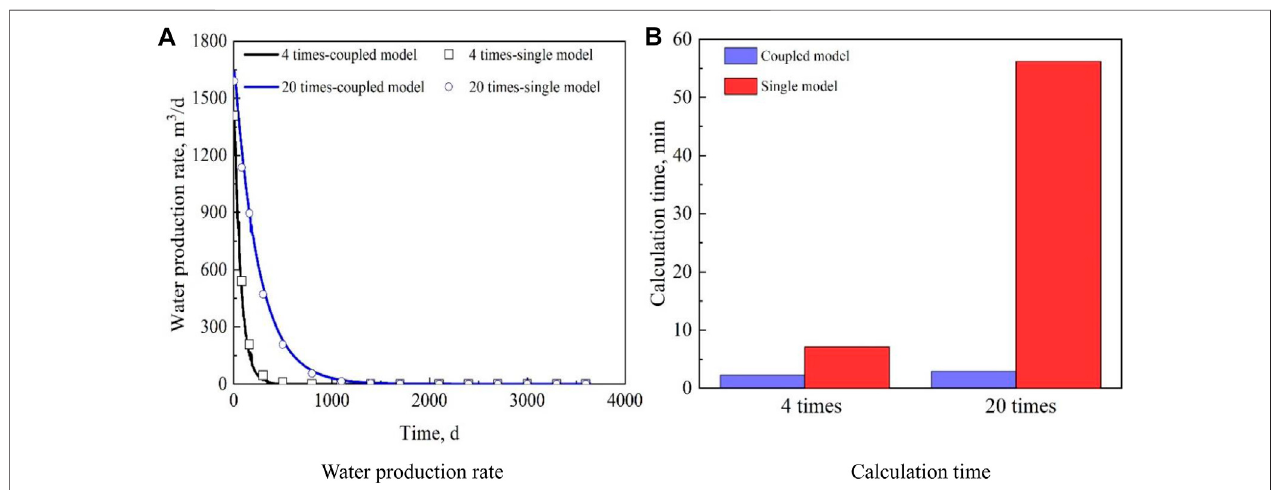
FIGURE 3 | Simulation results and calculation time comparison of the coupled model and single model. (A) Water production rate. (B) Calculation time.